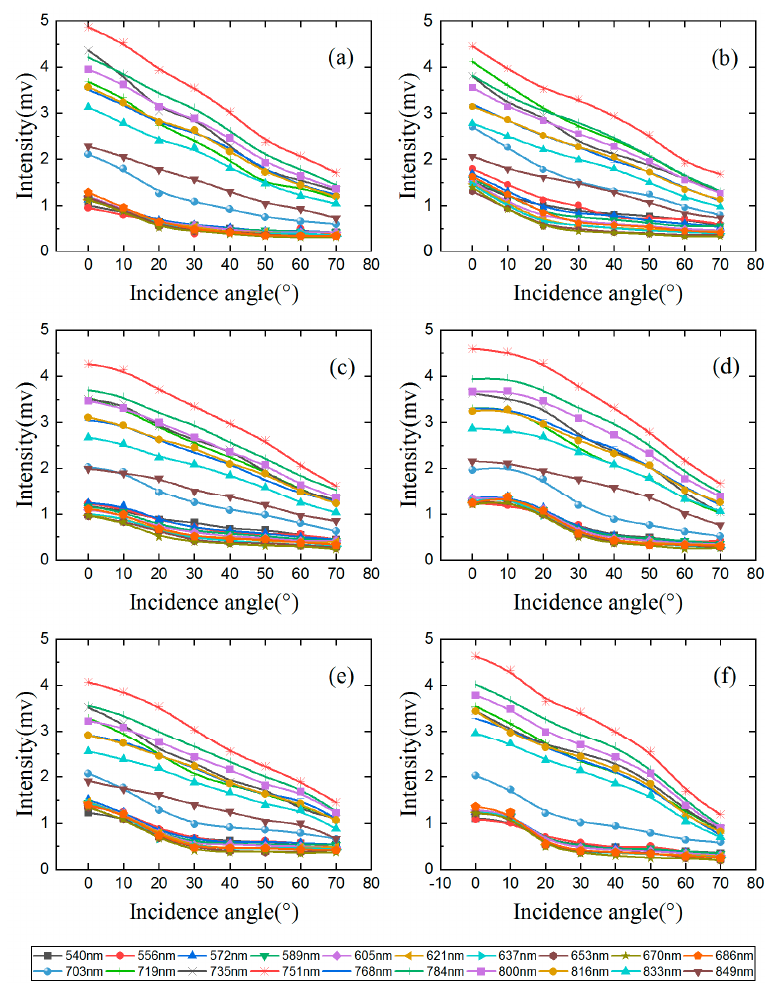
Figure 5. Backscatter intensities of twenty wavelengths of the six leaf targets versus incidence angle: ( a ) Ficus elastica , ( b ) Epipremnum aureum , ( c ) Aglaonema modestum , ( d ) Hibiscus rosa ‐ sinensis Linn , ( e ) Spathiphyllum kochii and ( f ) Kalanchoe blossfeldiana Poelln .